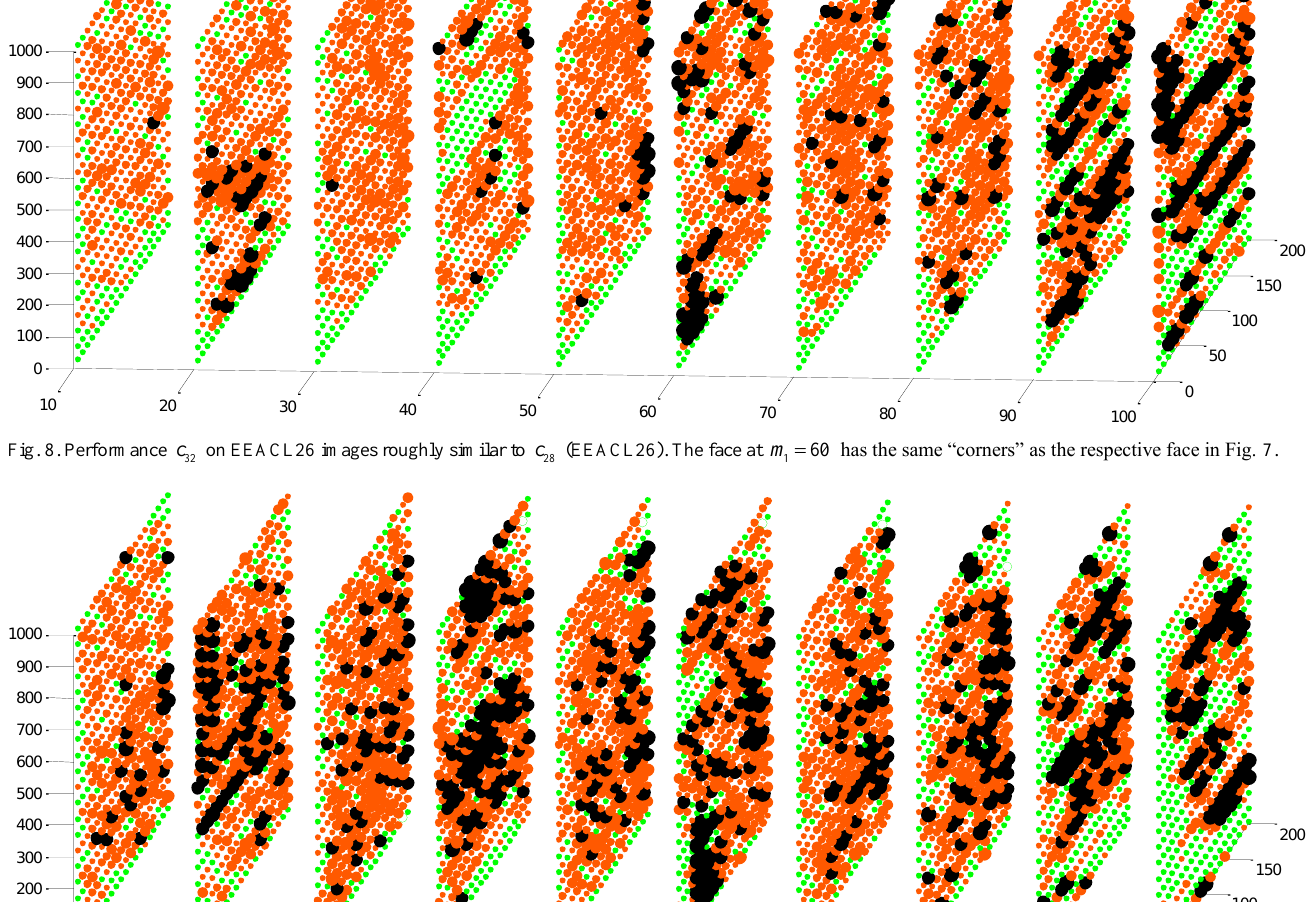
c and c . The quite unacceptable accuracies less than 50 % are circled 28 32